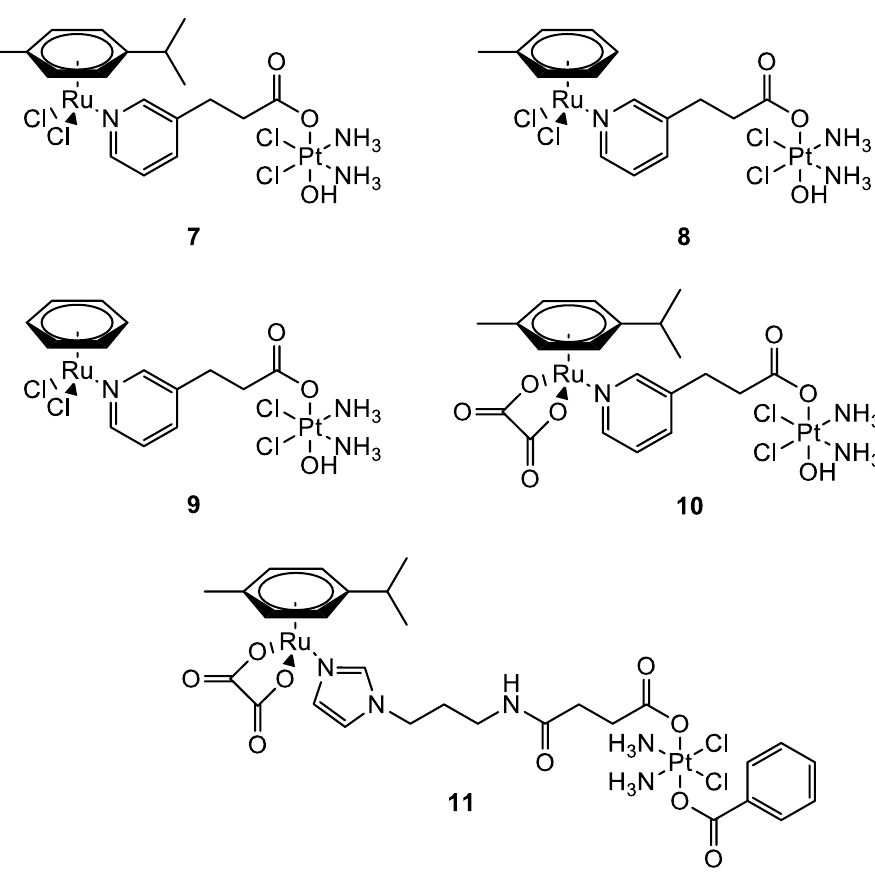
Figure 6. Molecular structure of compounds 7 – 11 .